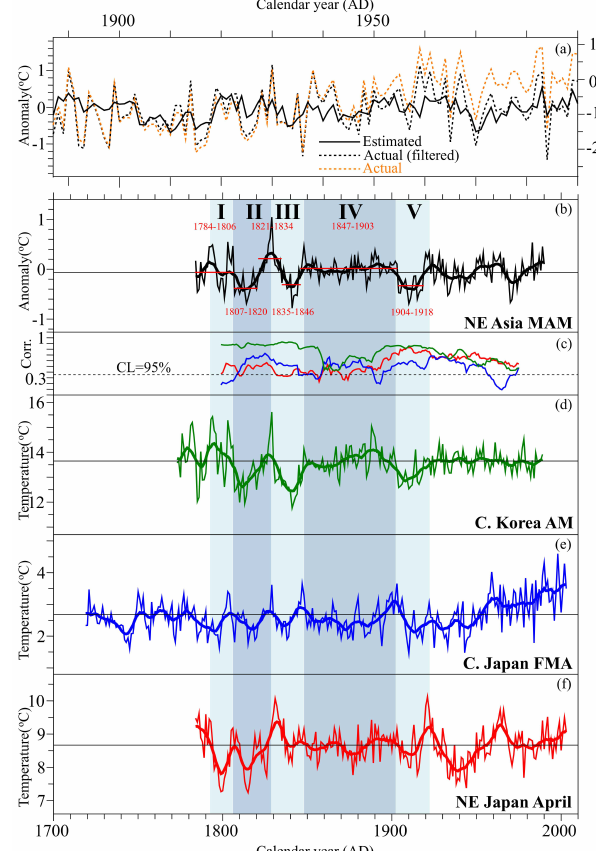
Fig. 3. (a) Estimated (solid line) and actual (dotted line) Mar– May (MAM) temperature anomalies for northeast Asia. The actual record (orange line) is prewhitened to fit the low-frequency vari- ability to the estimated series (see black dotted line). The left axis is for filtered actual and estimated records; the right axis for the actual record. (b) Reconstructed spring (MAM) temperature for northeast Asia. The horizontal red lines show regime shifts detected using intervention analysis (Rodionov, 2004). (c) 31-yr running correla- tions between R-NAST and the regional reconstructions (d – f) :